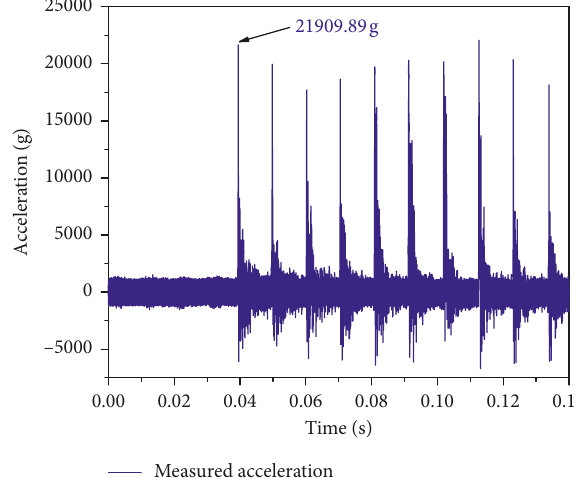
Figure 13: Acceleration of the stress wave verification experiment.